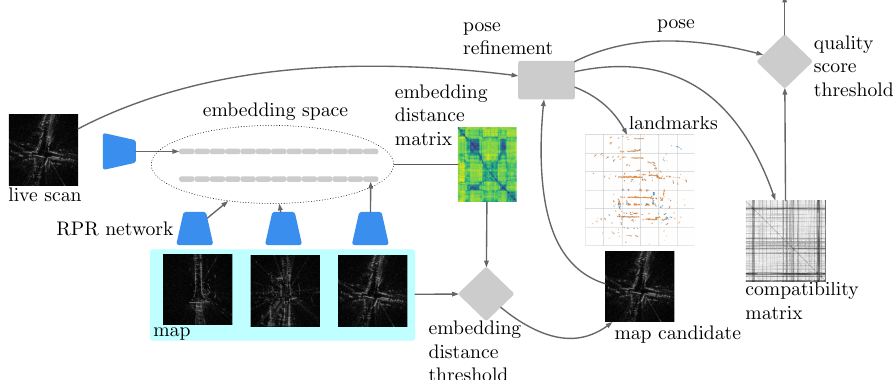
Figure 6. A block diagram illustrating the interaction of the two main submodules in our system: the radar place recognition (RPR) submodule described in Section 3.1 and the pose refinement module described in Section 3.2. A first drive-by of the route, which may be autonomous or piloted manually, is converted into a map of radar scans and their associated RPR embeddings—vectors of size 4096. Likewise, incoming (live) query radar scans are encoded by the feature extraction Convolutional Neural Network (CNN). The query embedding is associated with some subset of the map which is “close” in embedding space. We have illustrated here one such “closest” map frame. This map candidate and the query frame are then passed through the pose refinement module—a process which involves landmark extraction, data association, and rigid-body motion estimation. Importantly, to trade off online and robustness requirements, the two operating thresholds required must be tuned appropriately, as we cover in Section